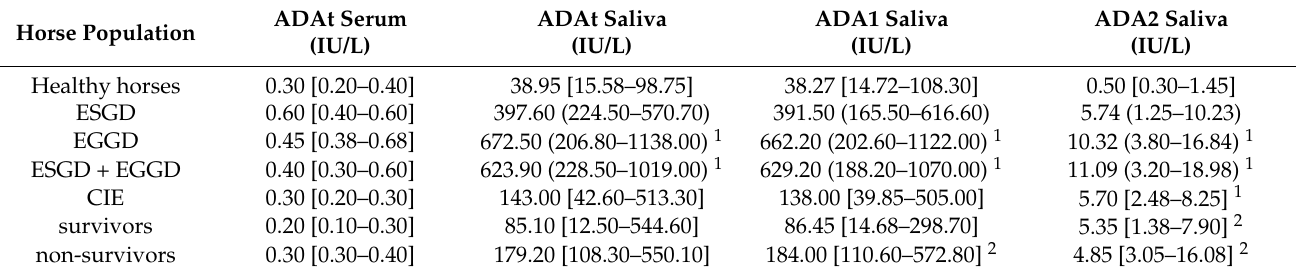
Table 4. Means and 95% confidence interval (CI) or medians and interquartile range [IQR] results of the total adenosine deaminase (ADAt) and isoenzymes (ADA1 and ADA2) in saliva and serum in